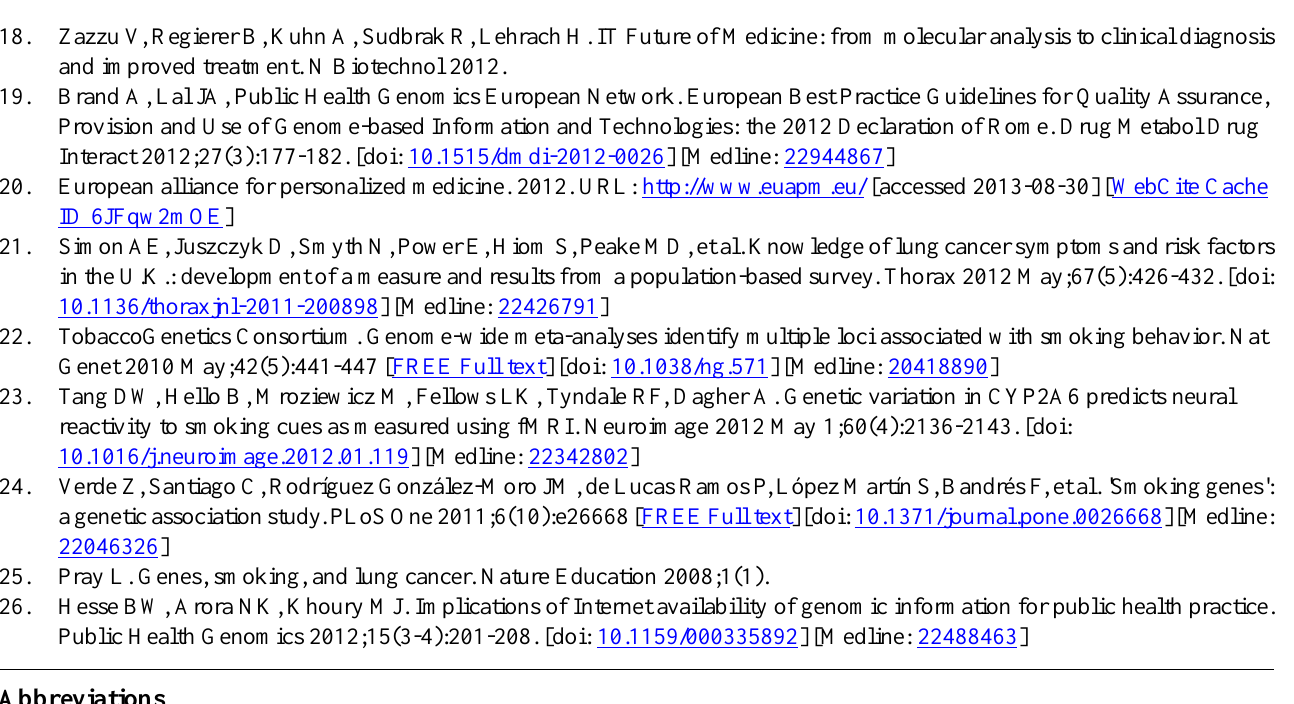
Abbreviations CHRNA3: Neuronal Acetylcholine Receptor subunit Alpha-3 COPD: Chronic Obstructive Pulmonary disease EAPM: European Alliance for Personalised Medicine ITFoM: IT Future of Medicine PHGEN: Public Health